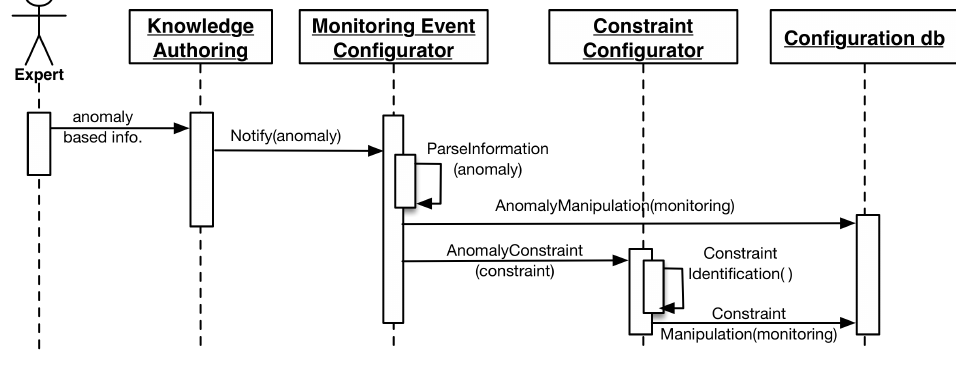
Figure 4. Sequence diagram of anomaly registration by the expert.